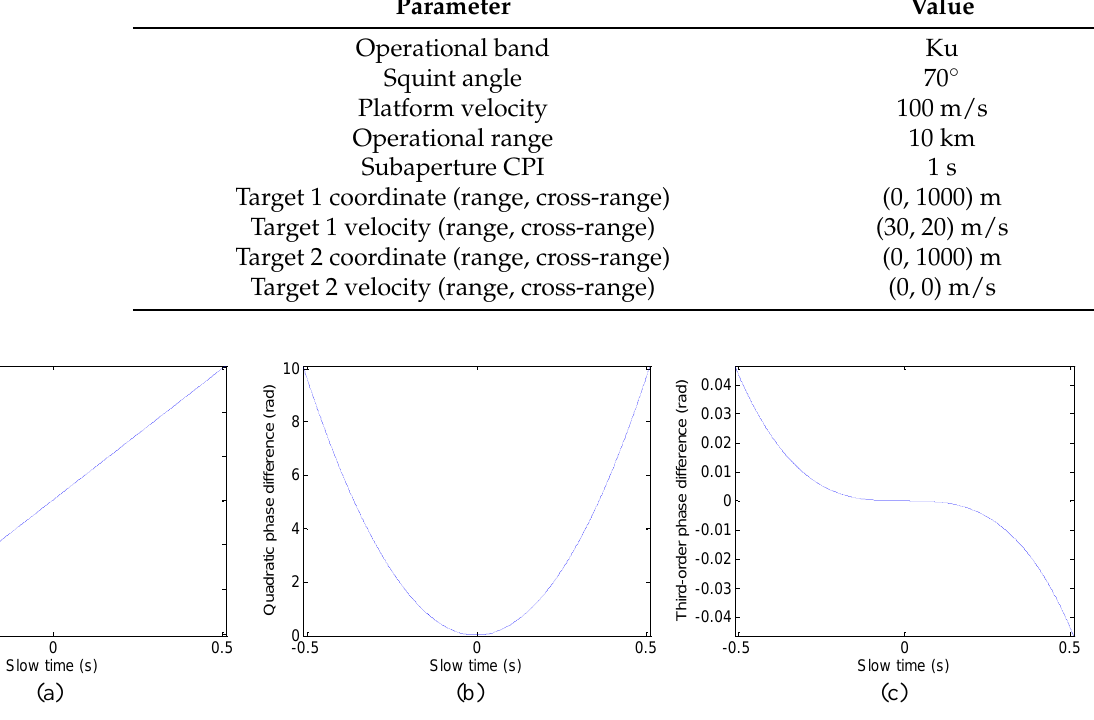
Figure 2. Range: Please add bold for abc in figure, same as others. cell migration and azimuth phase comparison. ( a ) Linear range walk difference. ( b ) Quadratic phase difference. ( c ) Third-order phase